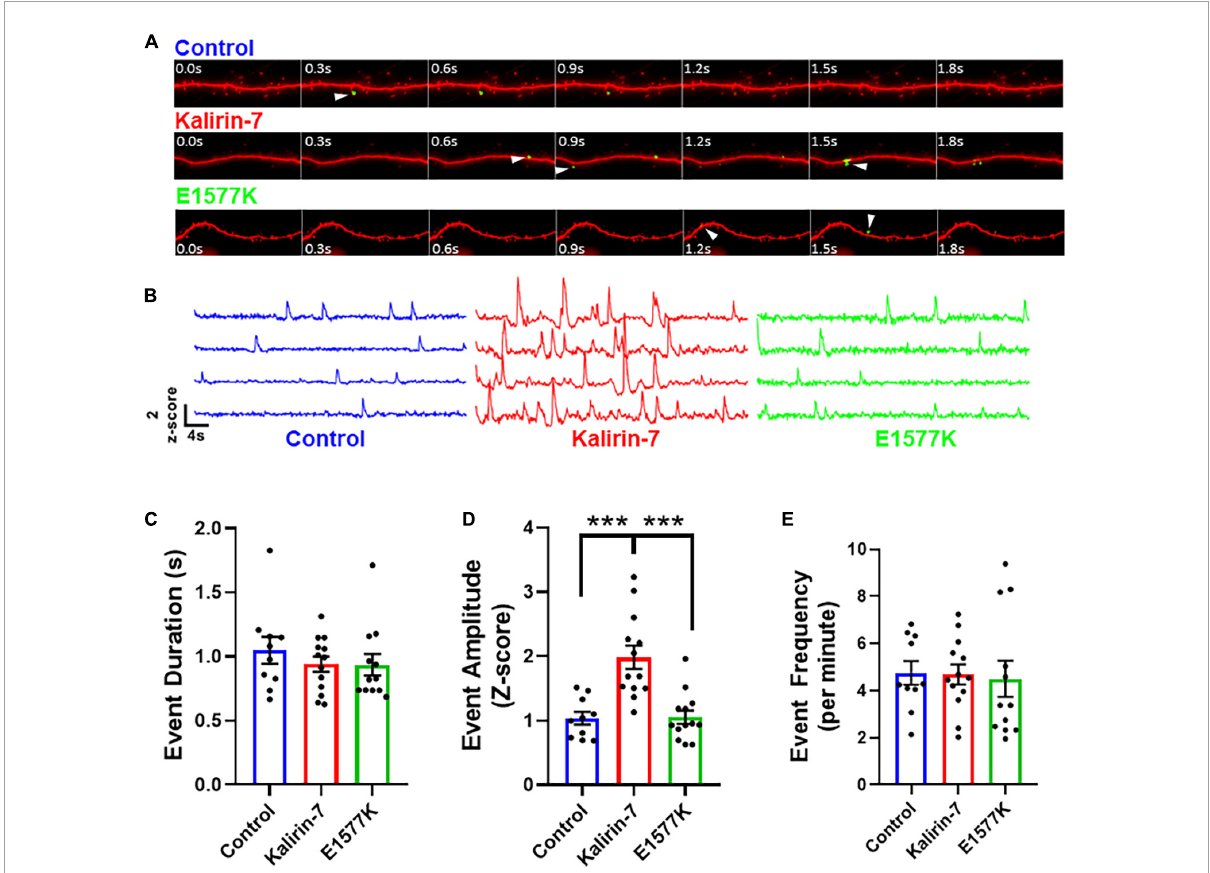
FIGURE5 E1577K fails to drive NMDAr-dependent calcium influx. (A) 4 s time course of GCamP6 Z-scored live imaging of dendrite with mCherry cell fill (red). Calcium events within spines (white arrowhead) indicate calcium entry through NMDAr channels for each indicated overexpression condition. (B) Representative GCamP6 Z-score traces of individual dendrite spines under each overexpression condition (control—blue, Kalirin-7—red, E1577K—green). Quantification of duration (C) , amplitude (D) and frequency (E) of GcamP6 events per individual spine,